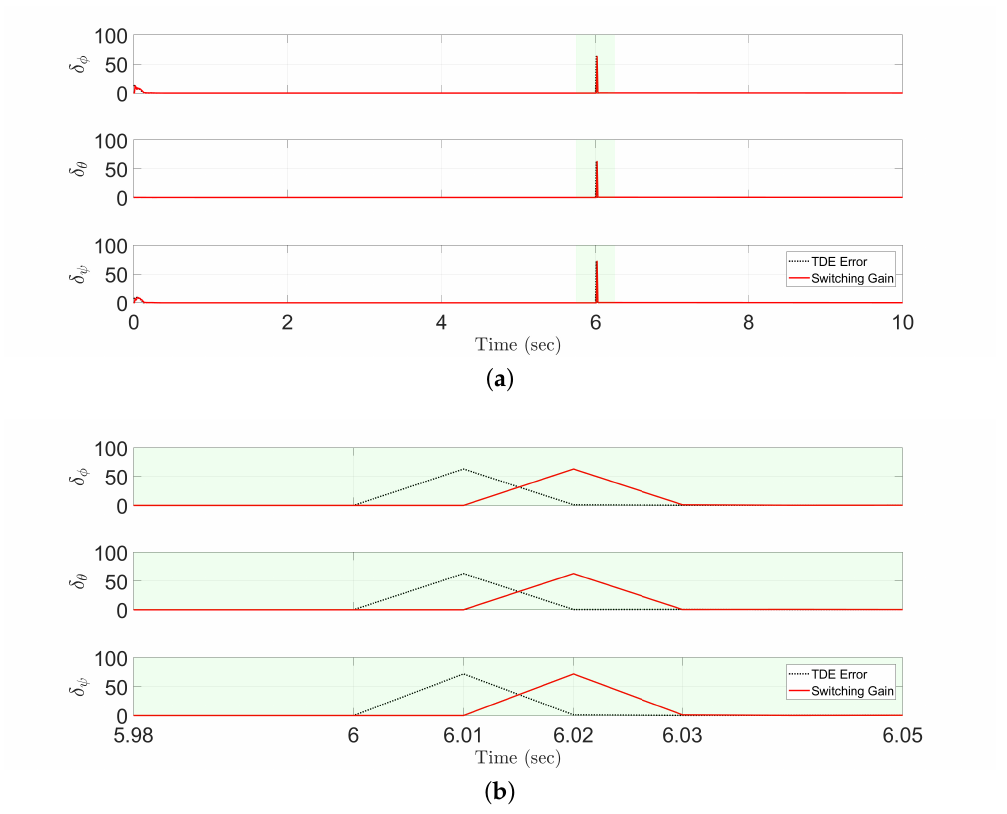
Figure 3. Comparison of the time-varying switching gains of the proposed ETDC scheme (solid line) and the TDE errors (dotted line): ( a ) overall scale; ( b ) partial